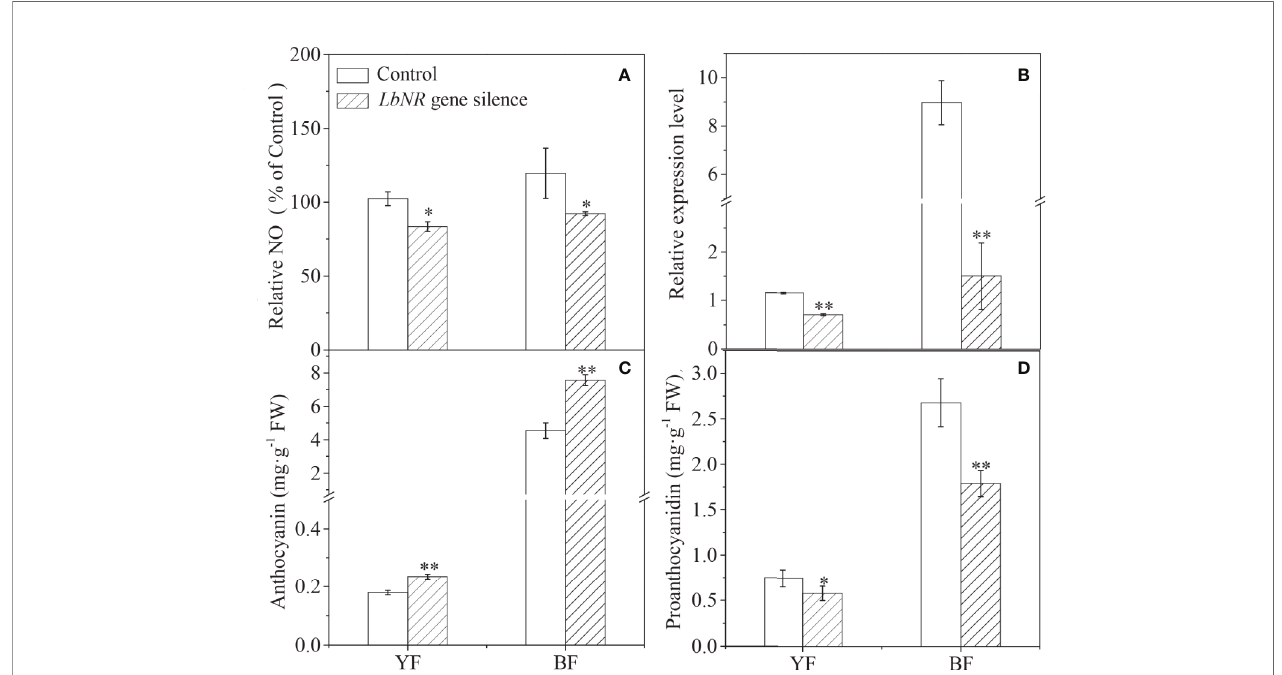
FIGURE 4 | Effect of virus-induced LbNR gene silencing on anthocyanin and PA accumulation in Lycium fruits. pTRV- LbNR vector construction and fruit injection were as described in Materials and Methods . After 3 days of Agrobacterium injection, the healthy modi fi ed YF or BF were sampled, immediately frozen in liquid nitrogen, and stored at − 80°C to assay the NO release by the DAF FM-DA-mediated spectro fl uorometric method (A) , to detect LbNR transcript by qRT-PCR (B) , to document anthocyanin and PA content by the spectrophotometric method (C) , or by HPLC method (D) , respectively. In (A) , the NO release was converted to relative values, in which the value of the empty vector-injected fruits was taken as 100%. The error bars represent the SDs of three independent replicates. The asterisks on the bars for the same species indicate signi fi cant differences between the treatments. “ * ” indicates p < 0.05, and “ ** ” indicates p <